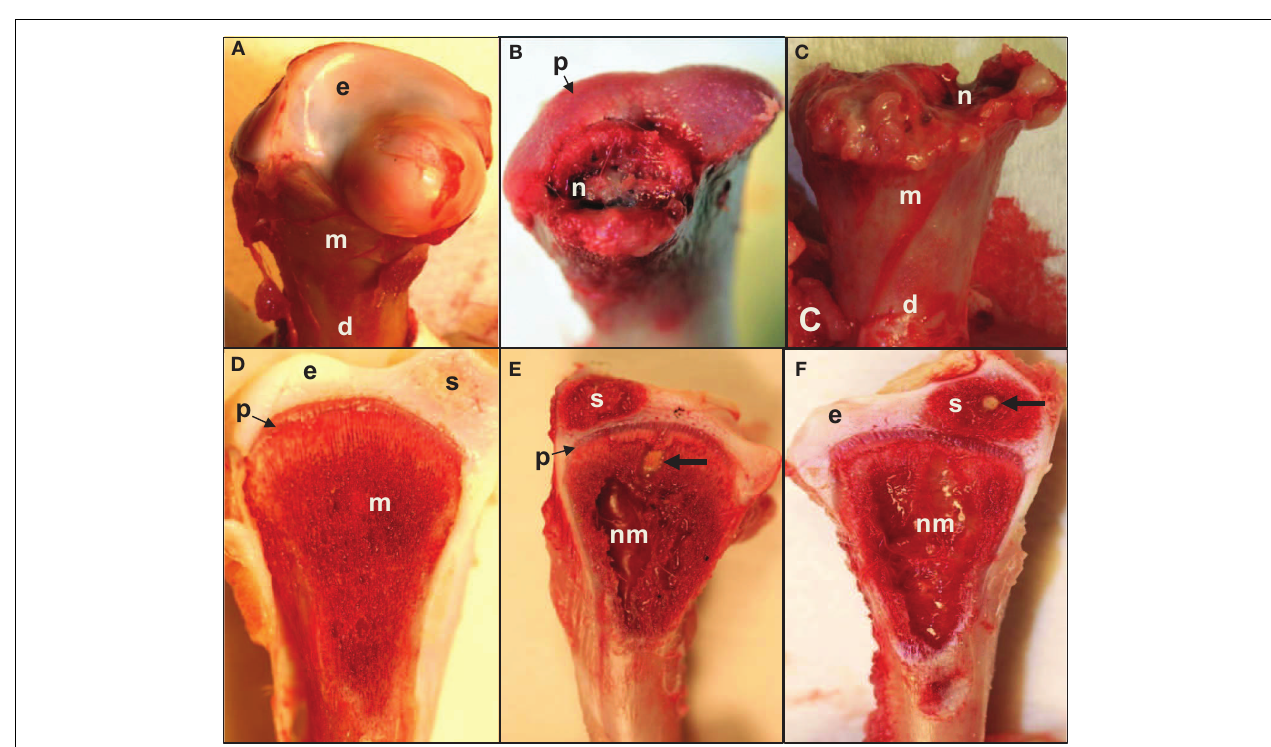
secondary center of ossification (s) develops in the tibial epiphyseal cartilage of broilers after (approximately) day 28. (E,F) Large zones of necrosis have destroyed the central metaphysis (nm) and bacterial sequestrate (thick arrows) can occupy the calcifying zone beneath the growth plate as well as in the secondary center of ossification (s). Histologic examinations revealed microbial foci within the metaphyseal parenchyma adjacent to necrotic voids, in agreement with previous reports (Mutalib et al., 1983a; McNamee and Smyth, 2000).Voids undercutting the bony support structure facilitate micro-fracturing of the epiphyseal-physeal cartilage (Wideman et al.,